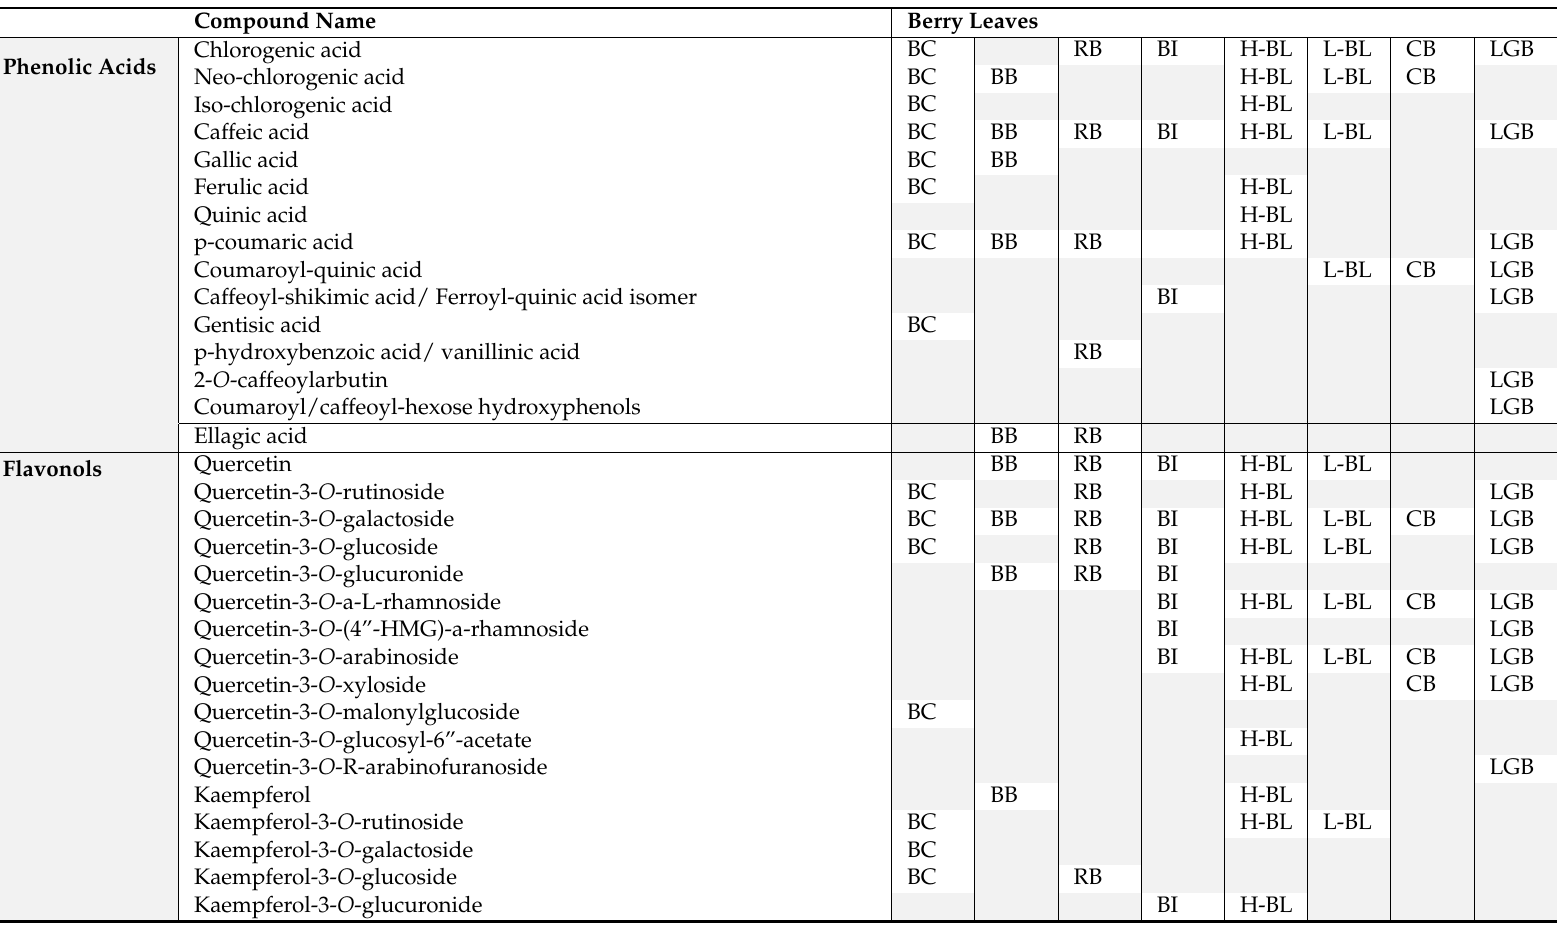
Table 1. An overview of the distribution of phenolic acids, flavonols, flavan-3-ols, ellagitannins (ET), proanthocyanidins (PACs), anthocyanins in blackcurrant (BC), blackberry (BB), raspberry (RP), bilberry (BI), highbush blueberry (H-BL), lowbush blueberry (L-BL), cranberry (CB) and lingonberry (LB)